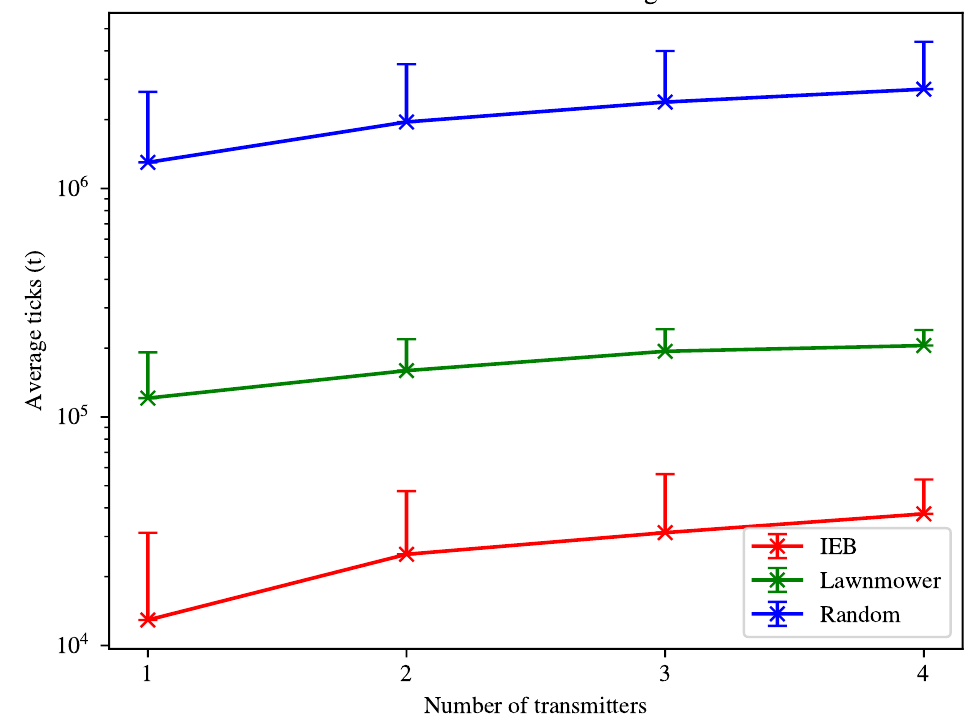
Figure 1. Time taken to find all transmitters within environment. Error bar indicates σ 2 standard